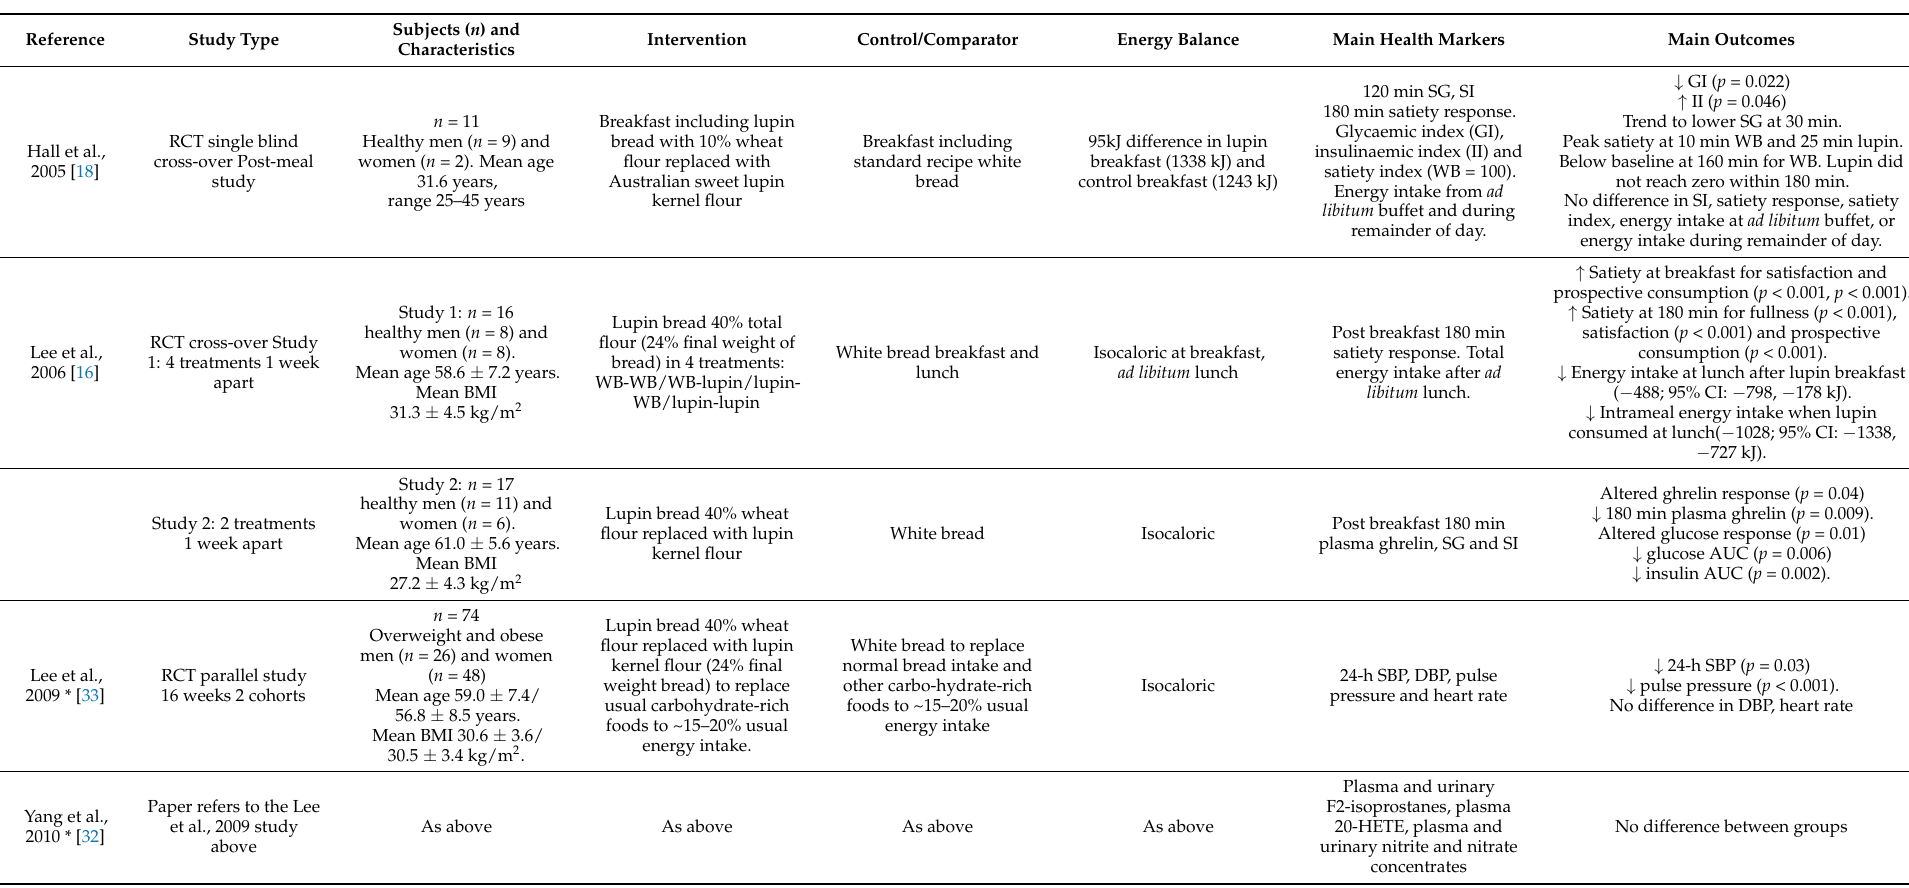
Table 2. Characteristics and major outcomes of studies examining whole lupin consumption and health